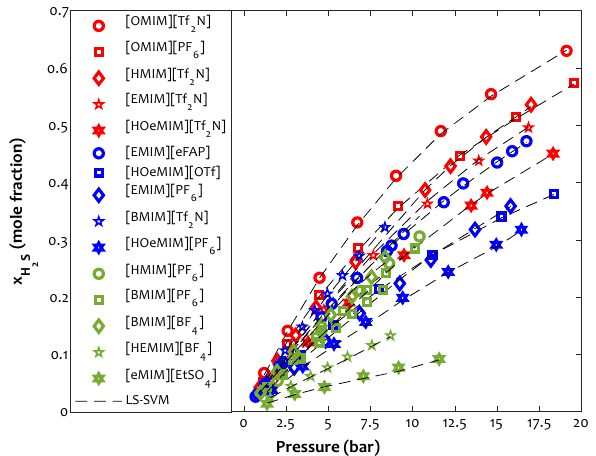
Figure 11. Comparing the H 2 S capture tendency of various ionic liquids at T = 333.15 K.